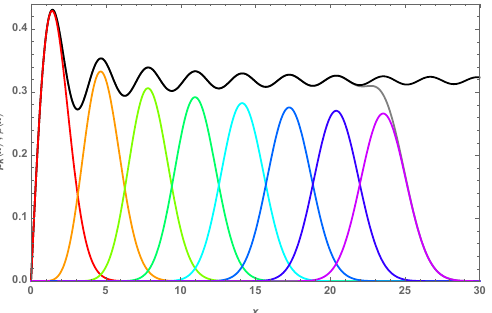
Figure 1 . First eight eigenvalue distributions p 1 ( x ) ; : : : ; p 8 ( x ) (red to purple), their sum (gray), and the microscopic spectral density (cid:26) ( x ) (black, normalized as (cid:26) ( 1 ) = 1 =(cid:25) ) of the quenched ( N F = 0) chiral Gaussian unitary